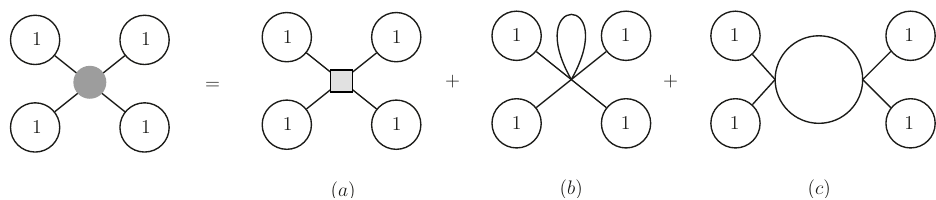
Figure 2 . Topologies entering in c 4 from higher-order contributions to the four-point interaction vertex. Diagram (a) denotes a LECs contribution, while diagram (b) and (c) represent a tadpole or rescattering topology,